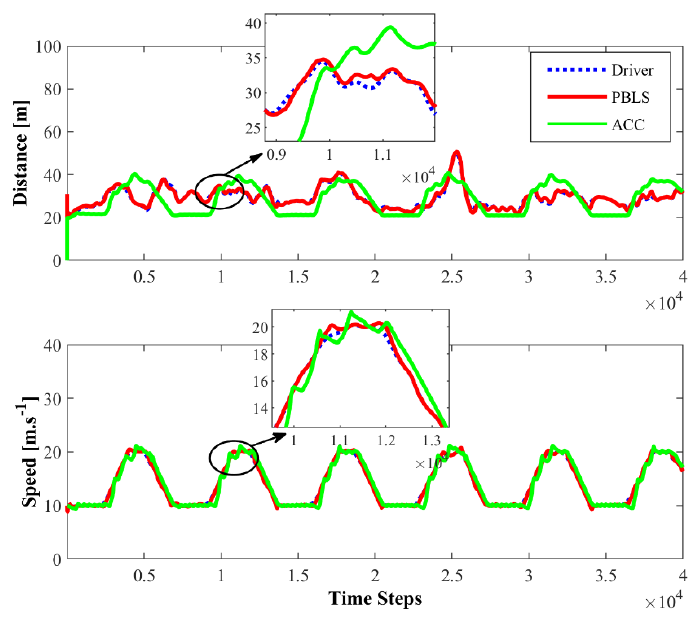
Figure 7. Distance and speed for Driving Scene I.